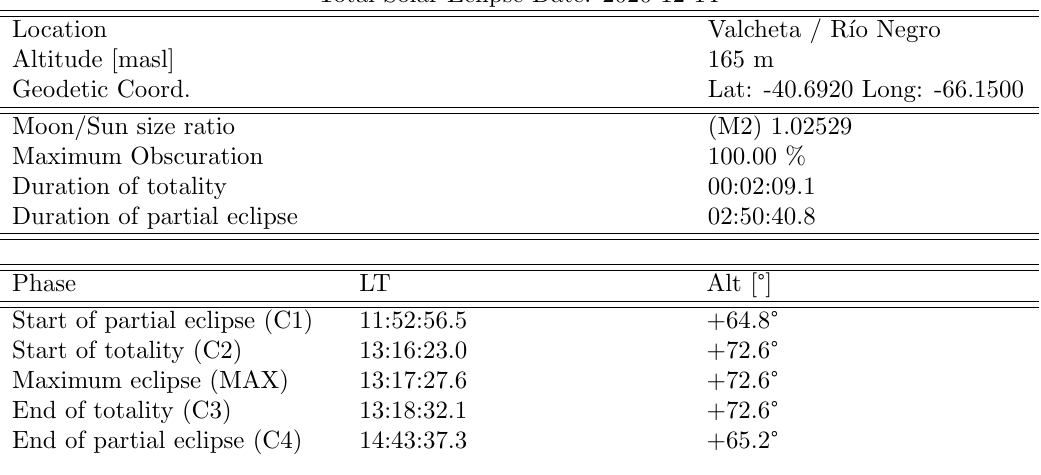
Table 1: Main circumstances of the total solar eclipse over Valcheta, Argentina. Total Solar Eclipse Date: